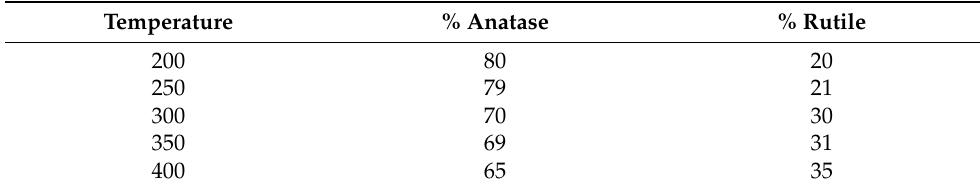
Figure 7. In situ XRD diffractograms of HCP25 at different temperatures. Table 1. Anatase and rutile percentage at different temperatures during in situ XRD of HCP25.